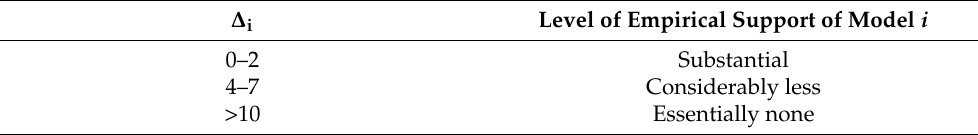
Table 2. Rules of thumb [36] for ∆ i = AIC i − AIC min .